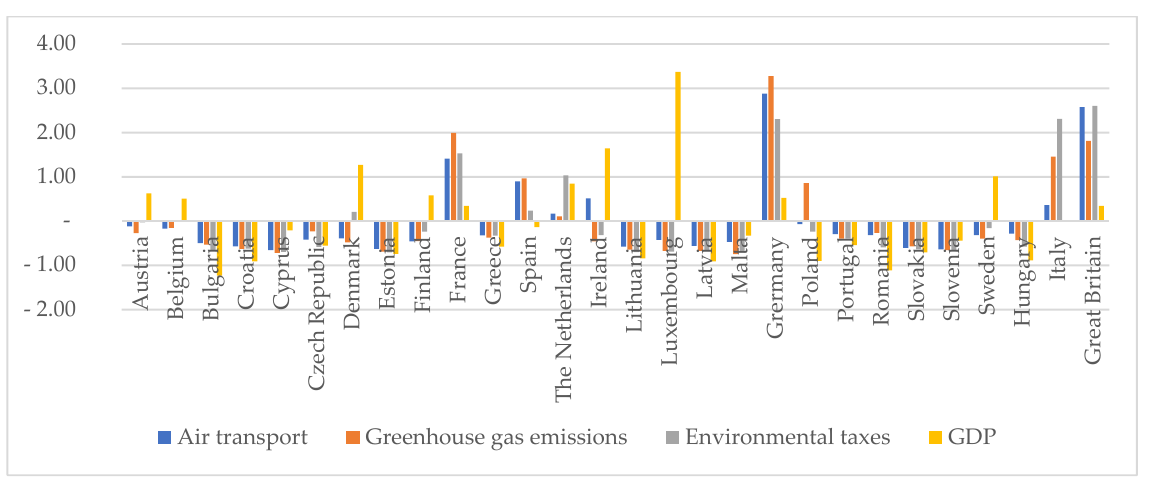
Figure A8. Distribution of European Union countries determined using Perkal index in 2015. Source: Reproduced from [16], Eurostat: 2009—2018.